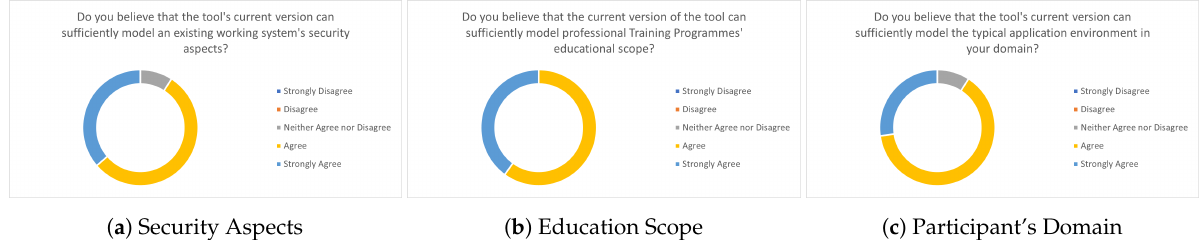
Figure 19. CTTP Models and programmes editors’ modelling capabilities. The subfigures present the responses on whether the CTTP model and programmes editor can sufficiently model ( a ) existing working system’s security aspects ( a ), ( b ) professional training programmes’ educational scope ( b ) and ( c ) the typical application environment in the participants’ domain ( c